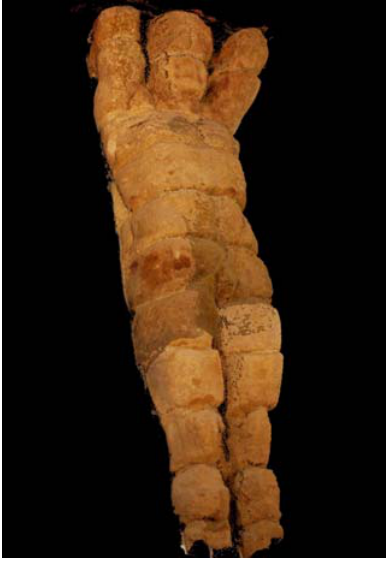
Figure 12. ZScan 3D Model